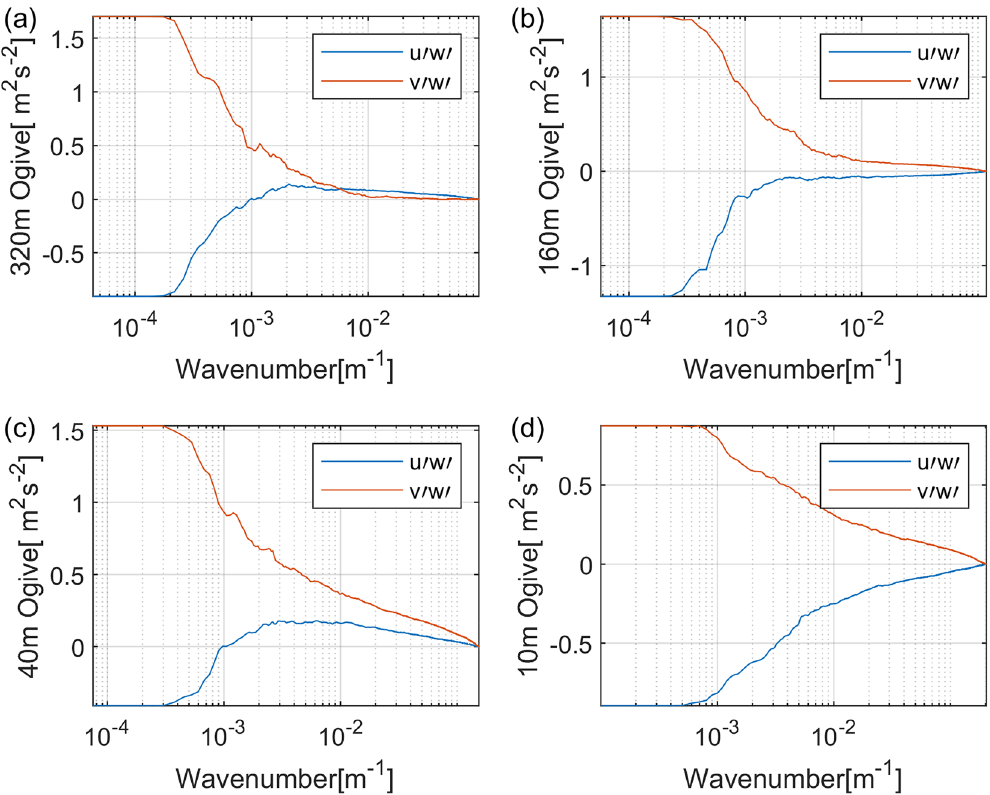
Figure 4. Cumulative sum of cospectrum (Ogive) curves of the two components of momentum fluxes verse the horizontal wavenumber at height ( a ) 320 m, ( b ) 160 m, ( c ) 40 m, and ( d ) 10 m. The record time is 2018-09-16